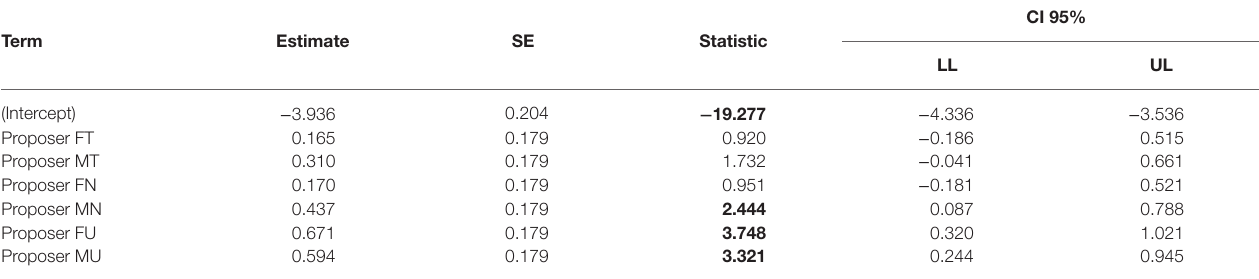
TABLE 2 | Fixed effects of proposers compared to